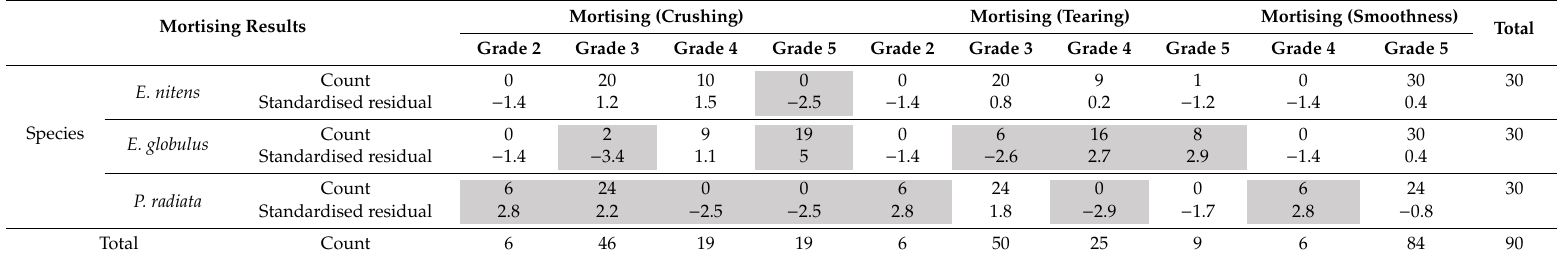
Table 6. Grading results according to mortising.